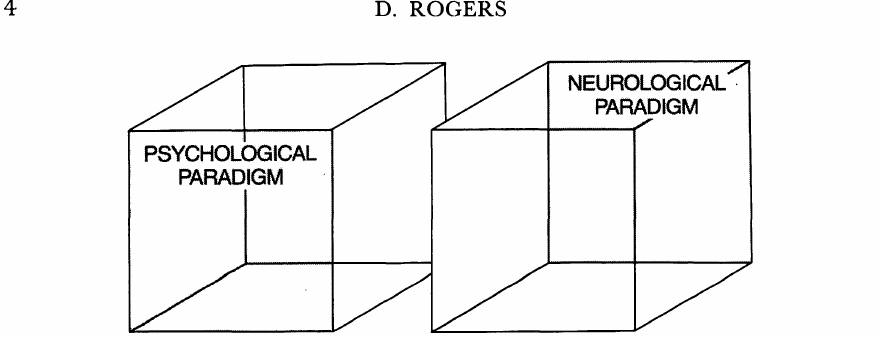
FIG. I. Psychological and neurological conceptions of psychiatric disorder-two legitimate but incompatible views of the same